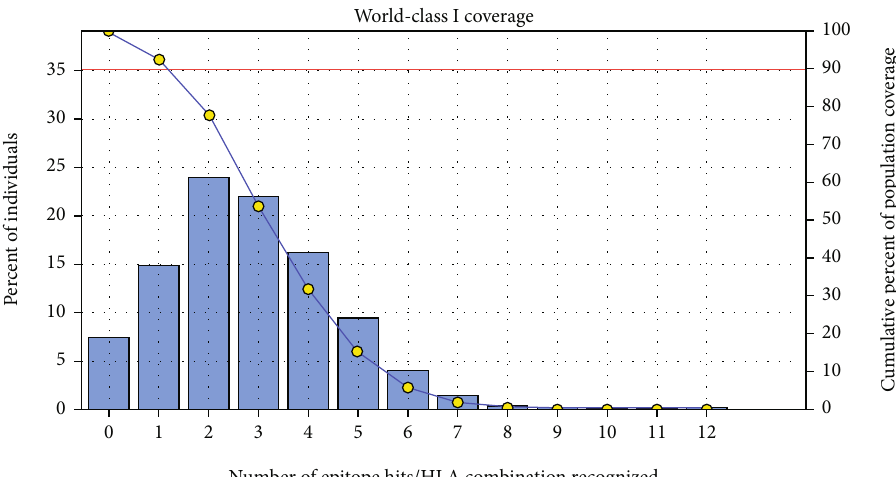
Figure 5: Global coverage for the top fi ve MHC I peptides (AVHEALAPI, KYFKRMAAM, QTSNGGAAY, RMAAMNQWL, and YFKEHGEPL). Note: in the graph, the line (-o-) represents the cumulative percentage of population coverage of the epitopes; the bars represent the population coverage for each epitope.